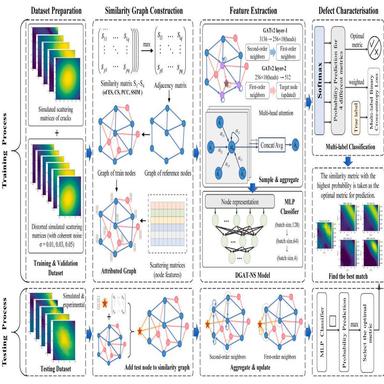
The proposed defect characterisation framework.